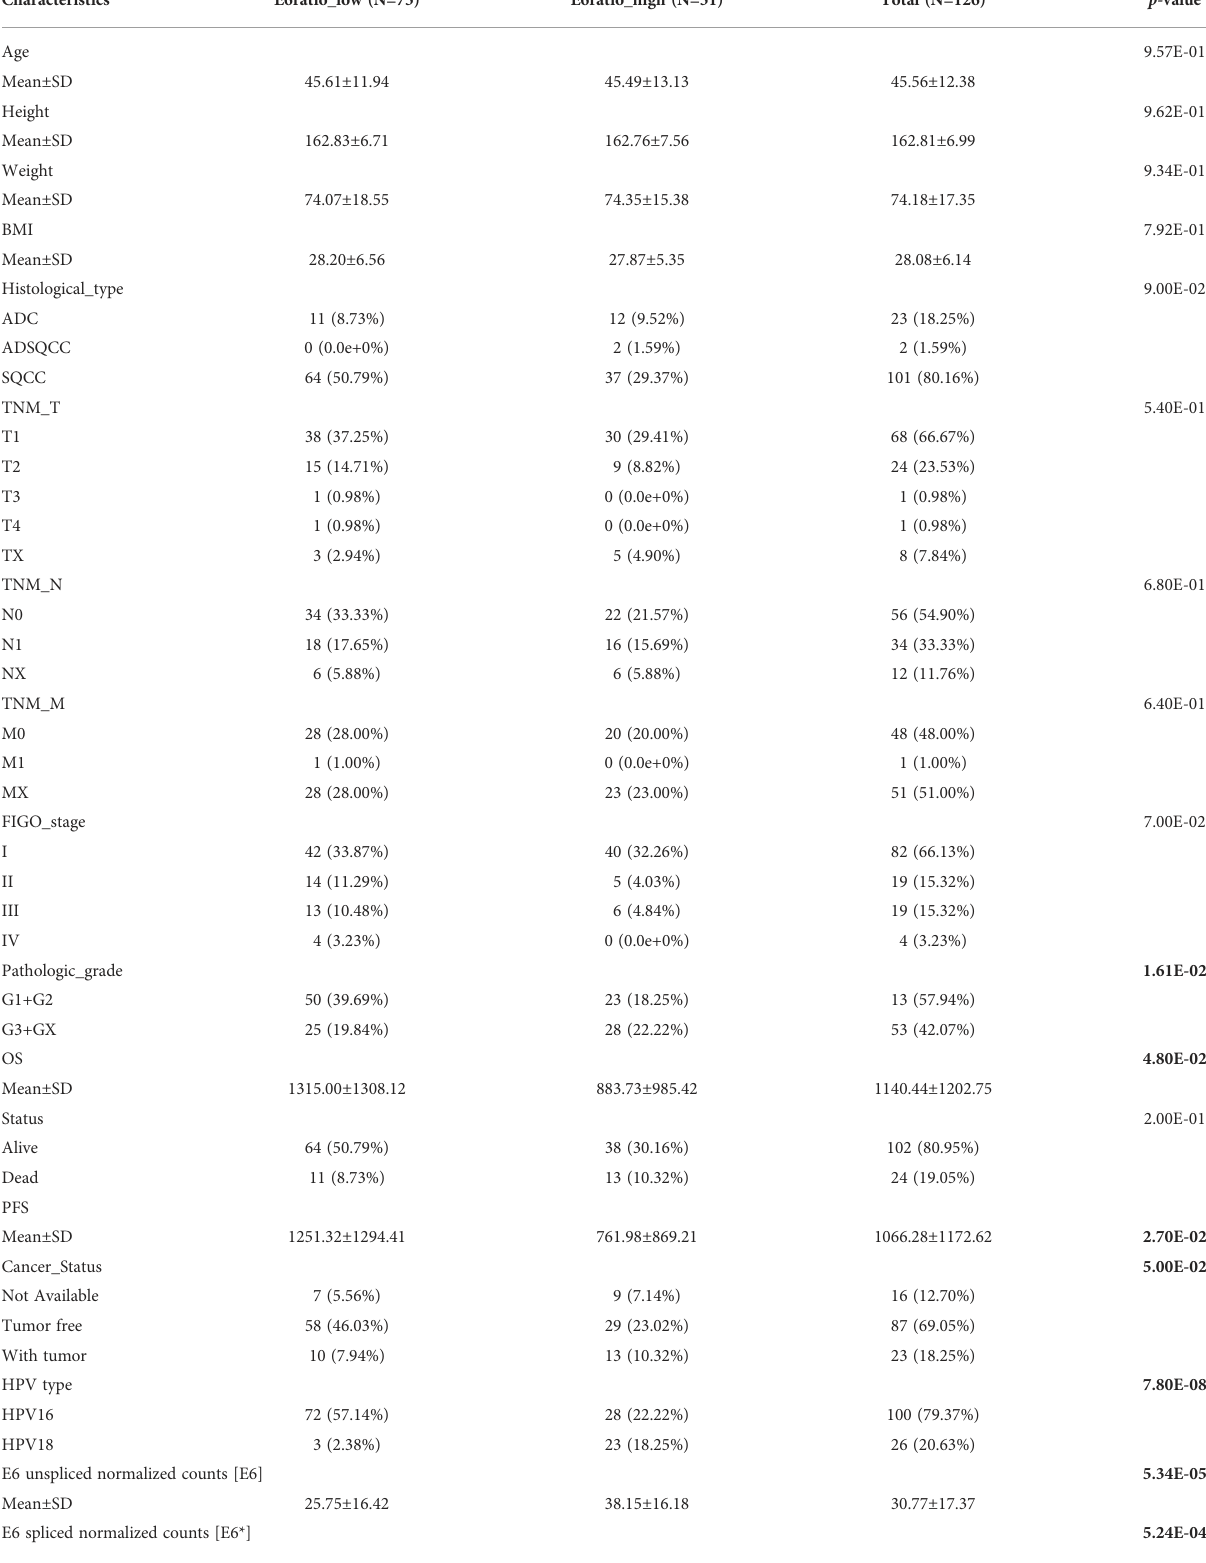
TABLE 1 Correlations between E6ratio and clinicopathological features of patients with cervical